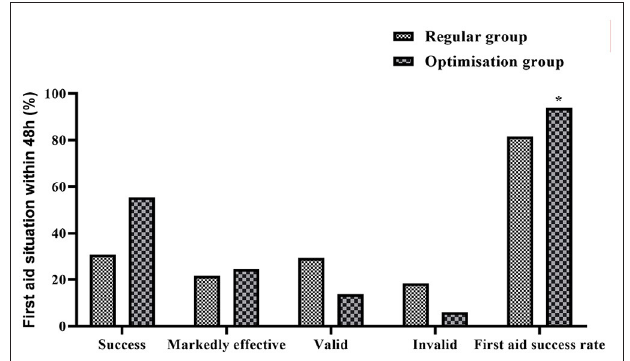
FIGURE 2 | Histogram comparing the success rate of resuscitation within 48h between the two groups. *Denotes comparison with regular group, P < 0.05.